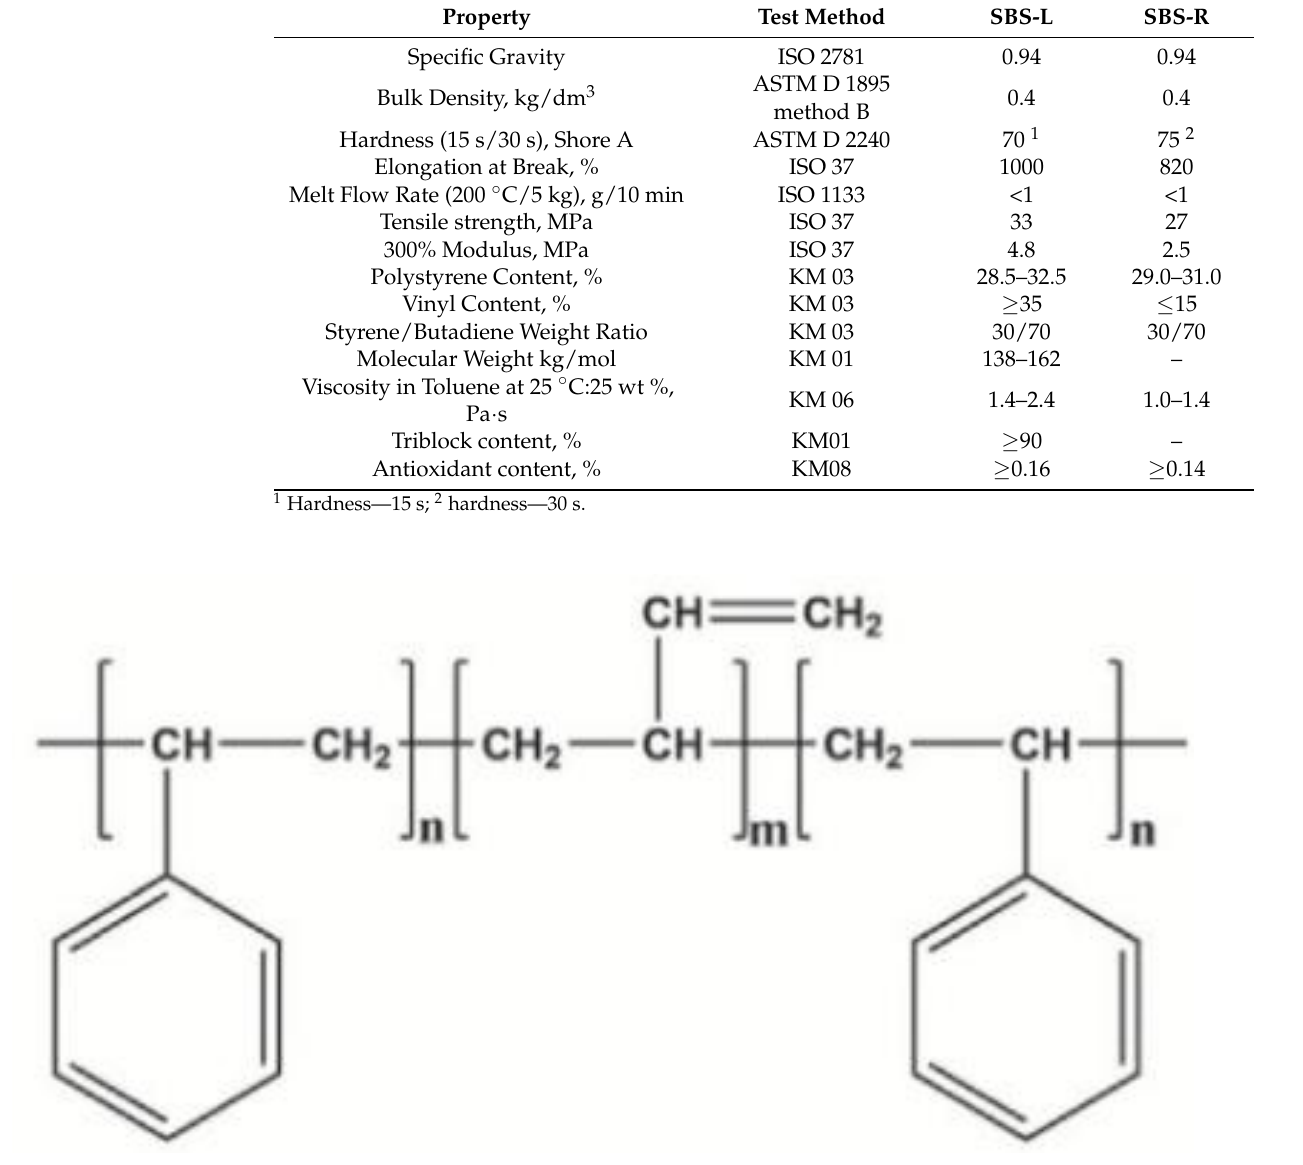
Figure 3. Structural formula SBS-L (high vinyl triblock). Reprinted from ref. [37].